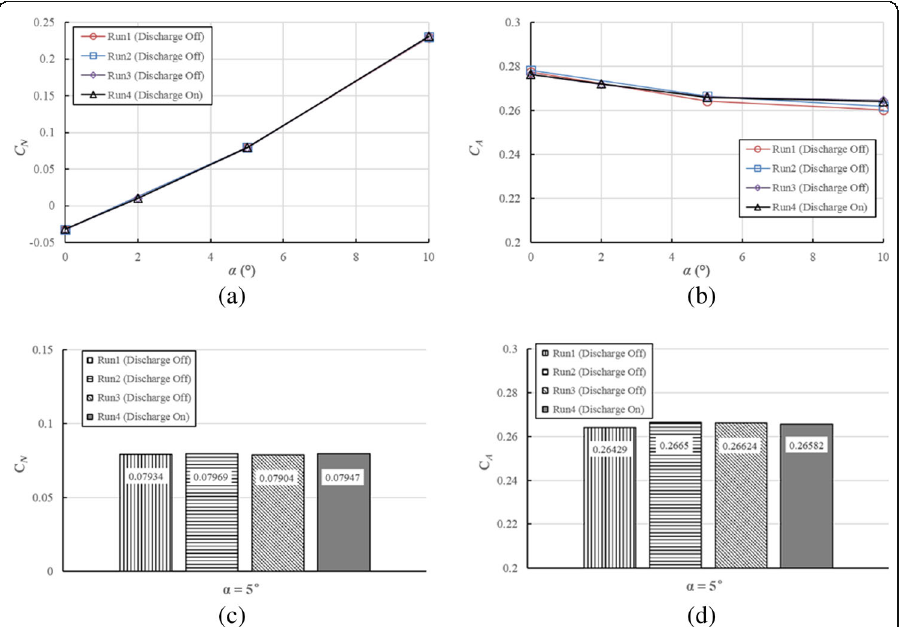
Fig. 8 Comparison of aerodynamic coefficients under the conditions of electric discharge off and on, ( a ) normal force coefficient C N , ( b ) axial force coefficient C A , ( c ) C N at α = 5° and ( d ) C A at α =